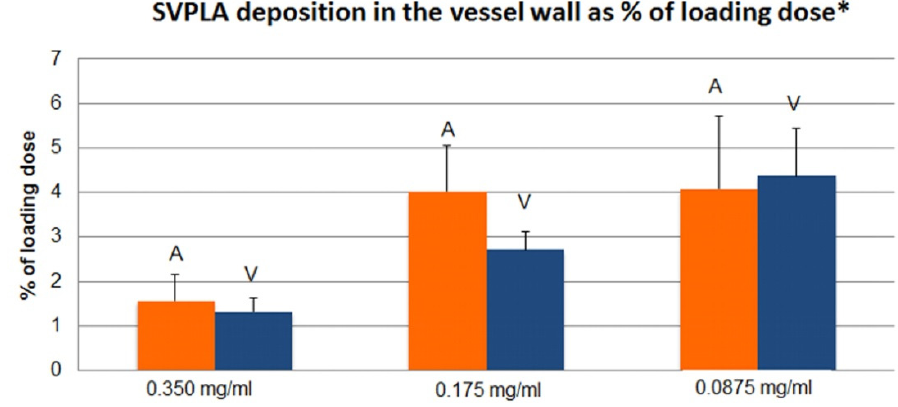
Figure 2. SV deposition in the vessel wall after administration of different concentrations of sus- pended SVPLA, expressed as a percentage of the total dose administered to the vessel (ia and iv). * p < 0.01 vs. control (Control; SV per os; no trace of SV in the vessel wall after p.os administration);